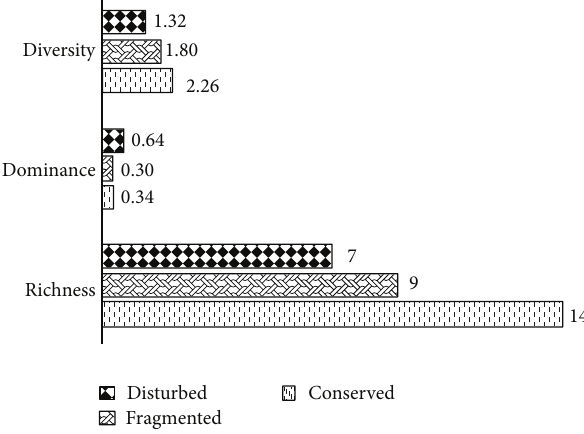
Figure 2: Cluster analysis of the capture in the agroecosystems. Table 3: Analysis of variance (ANOVA) between the agroecosys- tems. Agroecosystems